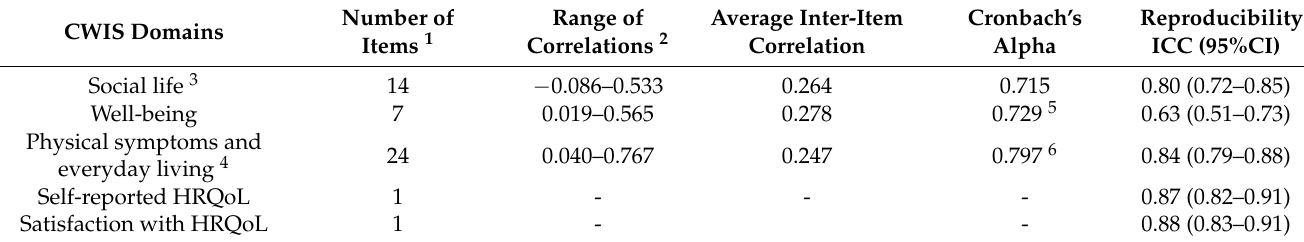
Table 2. Inter-item internal consistency and reproducibility of the Cardiff Wound Impact Schedule (CWIS) domains. CWIS Domains